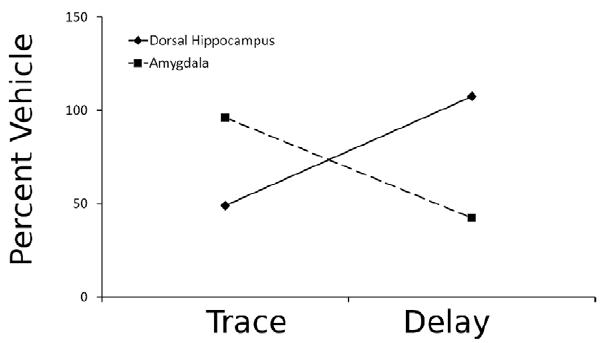
Figure 4. Double dissociation of effects of muscimol infusion on 2-pairing trace and delay cued freezing. Inactivation of the DH with muscimol produces deficits in trace but not delay conditioned CS freezing, while inactivation of the amygdala produces deficits in delay but not trace conditioned CS freezing. These findings suggest that amygdala independent circuitry can support trace fear conditioning. Data are Muscimol (0.25 ug/side) freezing to CS from experiments 1–4 as percent vehicle.